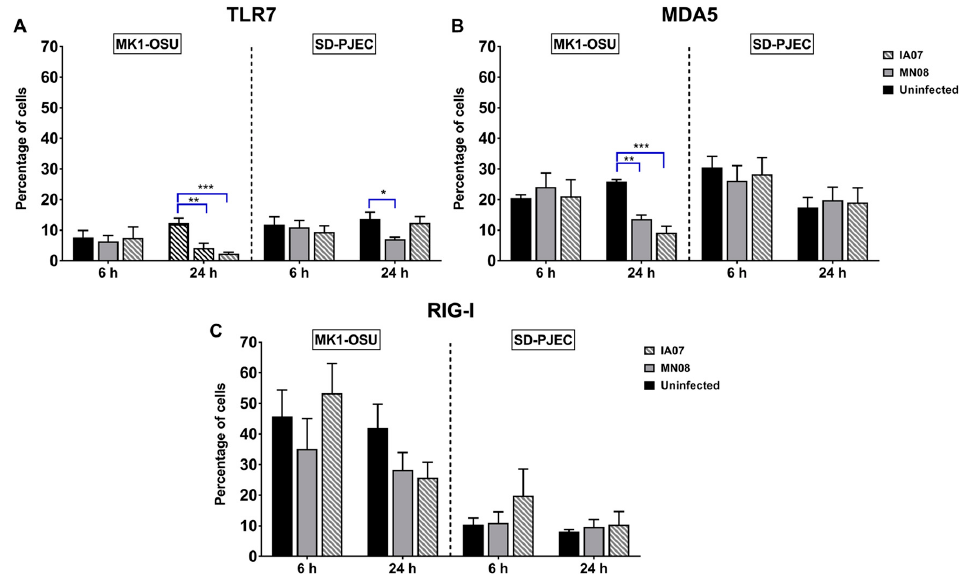
Figure 5. Expressions of TLRs and RLRs in MK1-OSU and SD-PJEC cells at 6 h and 24 h post-infection determined using a flow cytometer. MK1-OSU and SD-PJEC cells were infected with MN08 and IA07 viruses at MOI of 0.01 and incubated for 6 and 24 h at 37 °C. Cells were fixed and permeabilized using BD Cytofix/Cytoperm, incubated with primary antibodies, treated with biotinylated secondary antibody, and stained with streptavidin-FITC. ( A ) TLR-7 expression was decreased by both MN08 and IA07 in MK1-OSU cells 24 h post-infection but only by MN08 in SD-PJEC cells. ( B ) Expressions of MDA5 were reduced by MN08 and IA07 infection in MK1-OSU cells at 24 h but did not affect the expressions in SD-PJEC cells. ( C ) RIG-I did not alter due to treatments in both cell lines. Bars represent the mean for four to six experiments ± SE p < 0.05 (*) represented a significant difference between uninfected and infected cells. ** and *** represents p < 0.005 and p < 0.0005 respectively. Table 4. Percentage of cells expressing TLRs-2, -4, -5, -6, -8, and -9 in MK1-OSU and SD-PJEC cells 24 h after influenza virus infection as determined using a flow cytometer. Values represent the average for four to six experiments ± SE. There was no significant difference in the expression between the infected and uninfected cells.